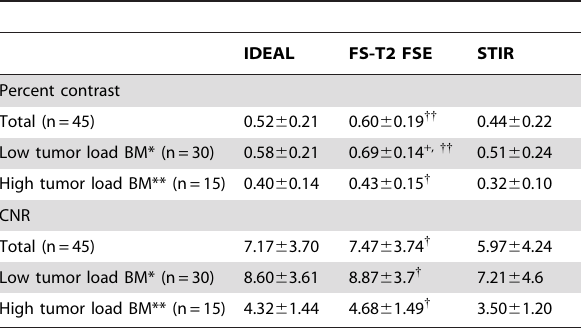
Table 3. Comparison of percent contrast and CNR among the three fat-suppression sequences in multiple myeloma.